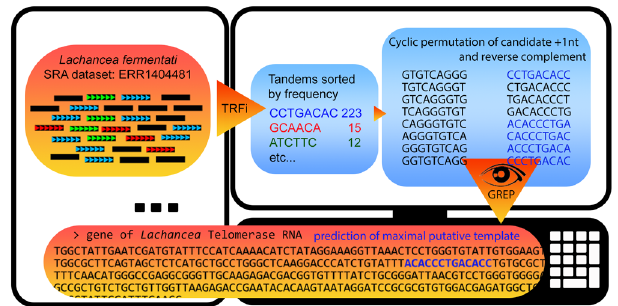
Figure 2. Example of the pipeline for finding telomere motifs and predicting template regions in Lachancea fermentati . NGS data in short reads were processed by Tandem Repeats Finder (TRFi) to obtain a list of tandem motifs sorted according to their frequency in the dataset (indicated by different colours). Permuted sequences and their reverse complements were checked using a full text search based on the grep command in a Linux terminal for their presence between the Ku binding hairpin and the Est1 binding site. (Figure created using Adobe Photoshop